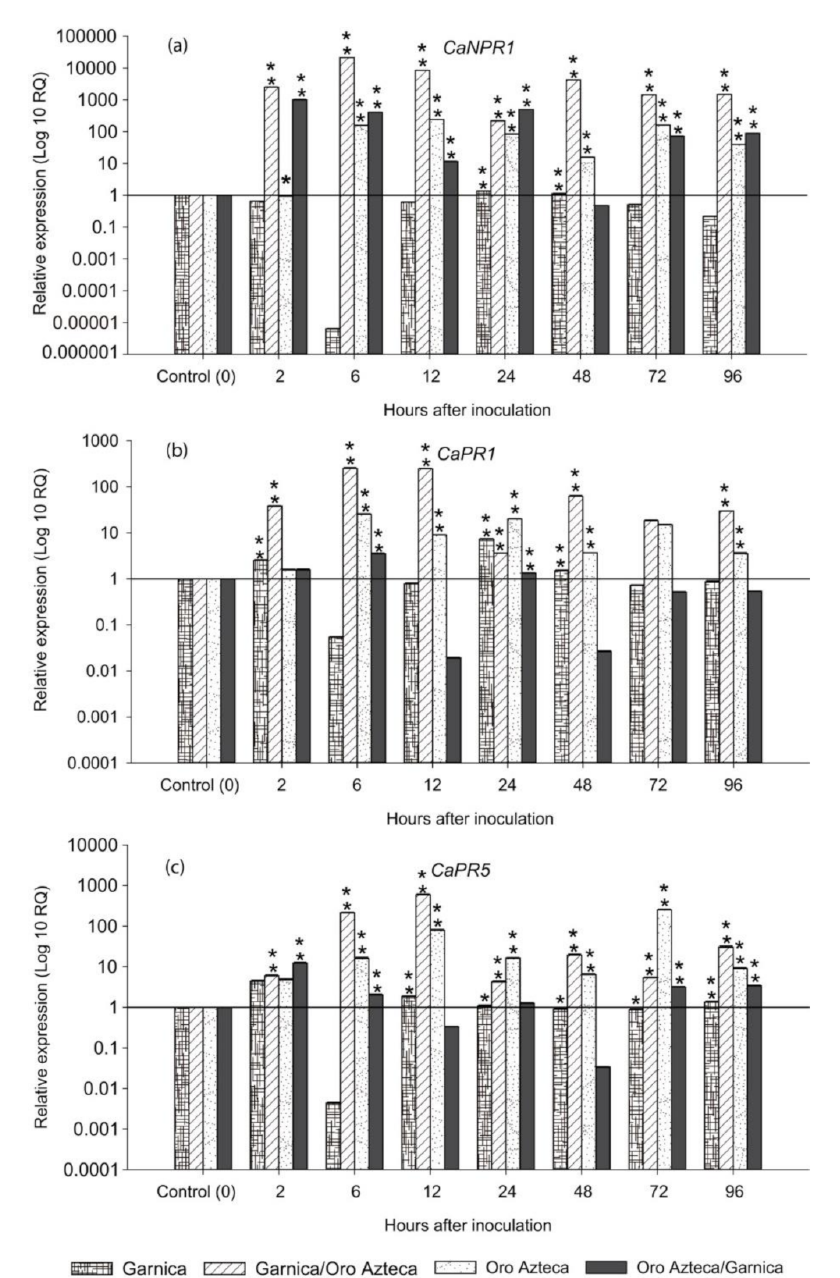
Figure 4. Relative expression of genes associated with the salicylic acid pathway, CaNPR1 ( a ), CaPR1 ( b ) and CaPR5 ( c ), in ungrafted and grafted plants during 96 hai and using as control ungrafted plants. * There were no significant differences between the control and the treatment. ** There were significant differences between the